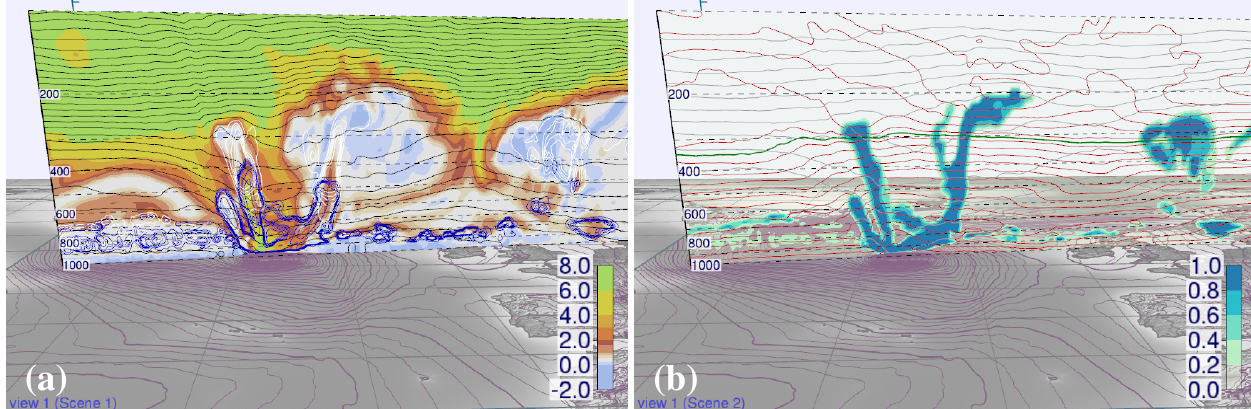
Figure 4. Vertical sections can be moved interactively in Met.3D to explore the vertical structure of the atmosphere, for example along potential flight track segments. (a) Potential vorticity (colour coding in PVU), (b) cloud cover fraction. Red colours in (a) mark the 2-PVU surface and thus the dynamic tropopause. Note the low tropopause along the trough. Same forecast as in Fig. 3 (animated version of this figure in the Supplement at 01:24min).